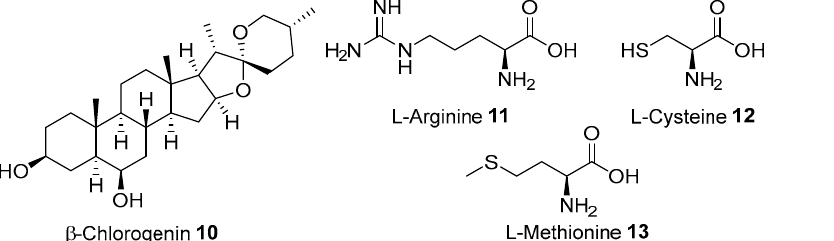
Figure 5. Wound healing compounds of medicinal plants used by Tenggerese (isolated from the same species found in other countries).